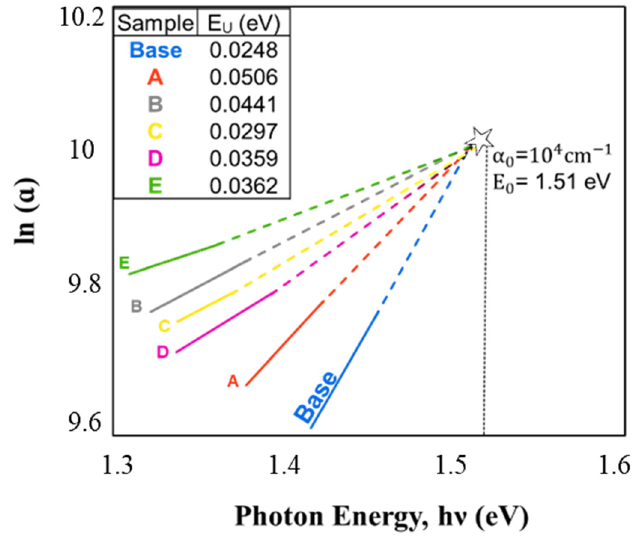
Figure 8. Urbach energy determination of CdTe film.